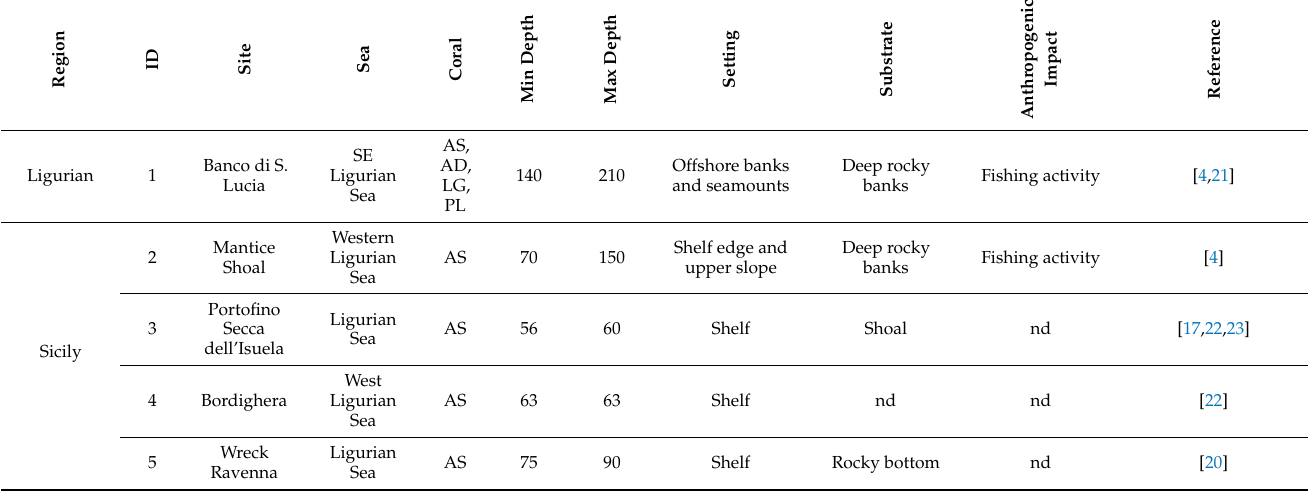
Table 1. Dataset of the Italian submarine sites associated with black corals reported in the available scientific literature. Codes used for the black corals: AS, Antipathella subpinnata ; AD, Antipathes dichotoma ; AF, Antipathes fragilis ; LG, Leiopathes glaberrima ; PL, Parantipathes larix . Code nd means “no